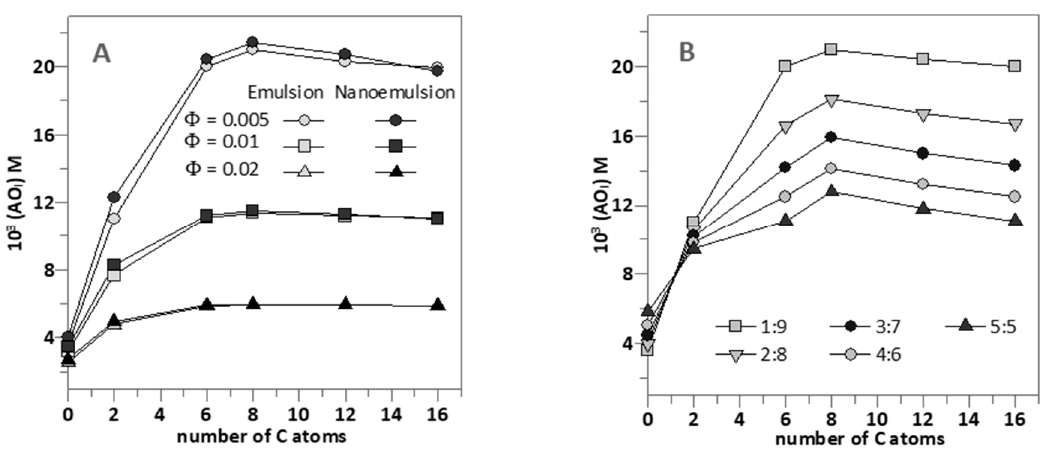
Figure 4. ( A ) Comparative interfacial concentrations of hydroxytyrosol and its derivatives (AO I ) in 1:9 (O / W) emulsions ( • − Φ I = 0.005, (cid:4) − Φ I = 0.01, (cid:78) − Φ I = 0.02) and 1:9 (O / W) nanoemulsions 1:9 (O/W) emulsions (  − Φ I = 0.005,  − Φ I = 0.01,  − Φ I = 0.02) and 1:9 (O/W) nanoemulsions ( − Φ I ( • − Φ I = 0.005, (cid:4) − Φ I = 0.01, (cid:78) − Φ I = 0.02) at di ff erent emulsifier volume fractions (Note the = 0.005, − Φ I = 0.01, − Φ I = 0.02) at different emulsifier volume fractions (Note the overlapping overlapping dark grey and light grey symbols). ( B ) E ff ect of O / W ratio on the interfacial antioxidant dark grey and light grey symbols). ( B ) Effect of O/W ratio on the interfacial antioxidant concentrations concentrations (AO I ) in nanoemulsions at Φ I = 0.005. In both figures, [AO T ] = 0.125 (AO I ) in nanoemulsions at Φ I = 0.005. In both figures, [AO T ] = 0.125 mM.